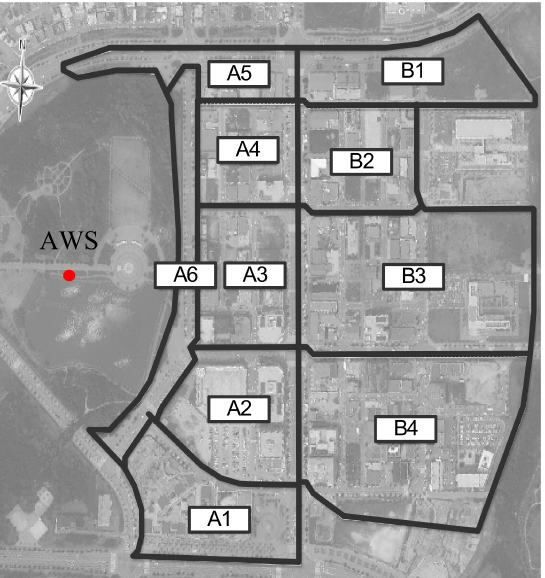
Figure 1. Total drainage area of the study site at the Ochang Science Industrial Complex, Cheongju, South Korea, showing the 10 sub-basins considered in this study. In the figure, the red point indicates the nearest automatic weather station (AWS) around the drainage area. Table 1. Overview of LID installations in the study site and their functions: infiltration (IN), filtering (FI), storage (ST), evapotranspiration (EV), ecological habitat (EC), and groundwater supply (GW). “X” indicates that a given installation provides that function; “n/a” indicates that it does not. Function LID Installation